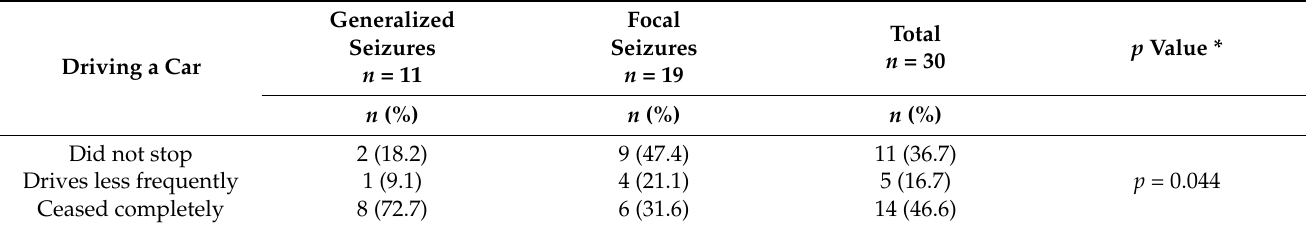
Table 6. Influence of type of epileptic seizure on driving vehicles in patients with brain